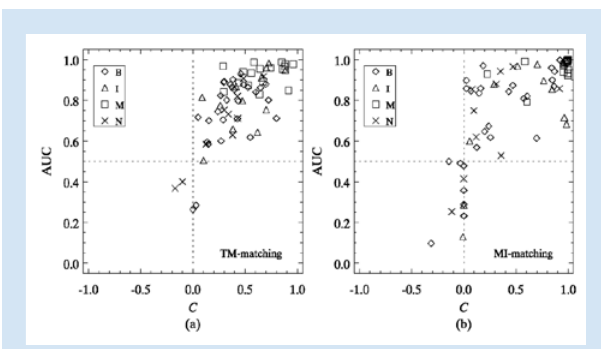
Fig. 5. Scatter plot of AUC v. C with the best matching accuracies for each mammogram pair for (a) TM-matching and (b)